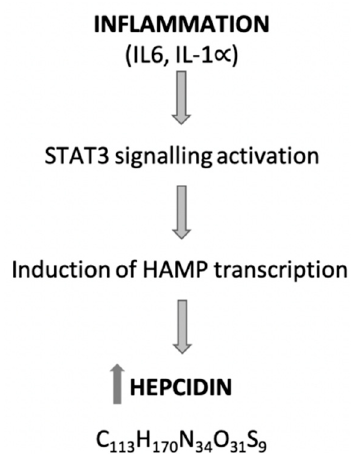
Figure 3. The generation of hepcidin in the inflammatory process. STAT3 activation requires the presence of SAMD4 because its absence prevents STAT3-mediated hepcidin gene expression [58]. This process can be framed within the inflammatory process of AP. IL: interleukin; STAT3: signal transducer and activator of transcription-3; HAMP: hepcidin antimicrobial